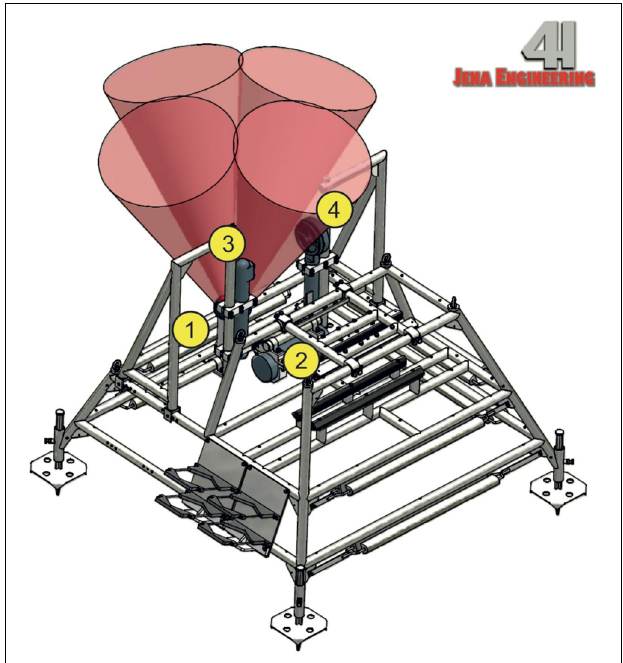
FIGURE 10 | Sketch of the Zooplankton Observatory consisting of (1) a Workhorse Sentinel ADCP (1200 kHz), (2) VPR electronics housing assembly, (3) camera housing assembly and (4) strobe light housing